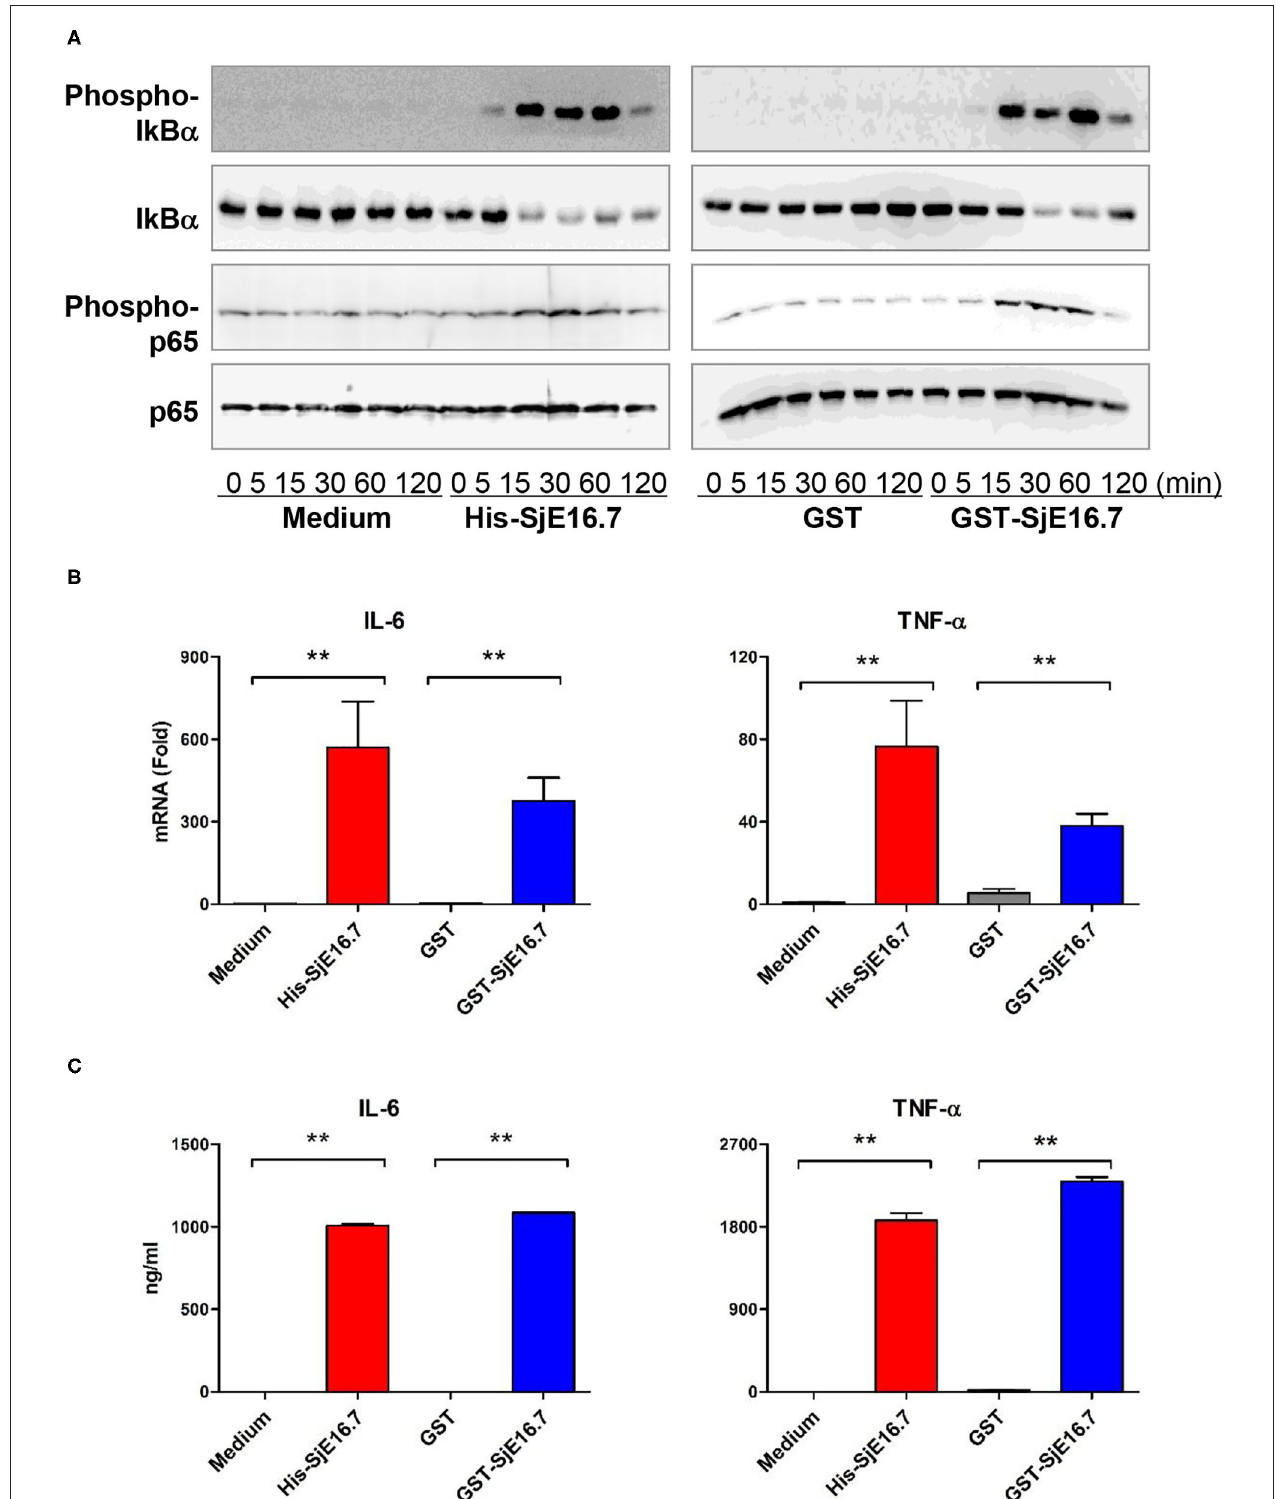
FIGURE 3 | SjE16.7 induces NF- κ B signaling activation and proinflammatory cytokine production. (A) BMDMs were stimulated with 1 µ M eukaryotic recombinant protein His-SjE16.7 or prokaryotic recombinant protein GST-SjE16.7, or GST control, for the indicated times, and the levels of phospho-I κ B α , total I κ B α , phospo-p65,